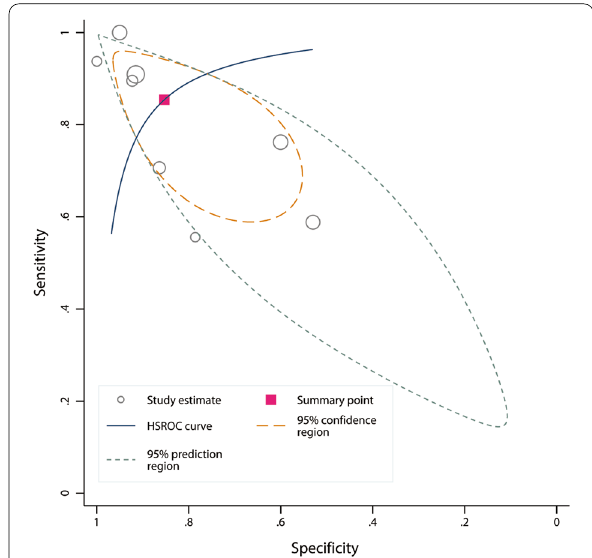
Fig. 3 HSROC curve of dynamic arterial elastance for predicting the MAP response to fluid expansion. The size of the circles indicates the weight of the individual studies. The area under the hierarchical summary receiver operating curve was 0.92 (95% CI 0.89 to 0.94)